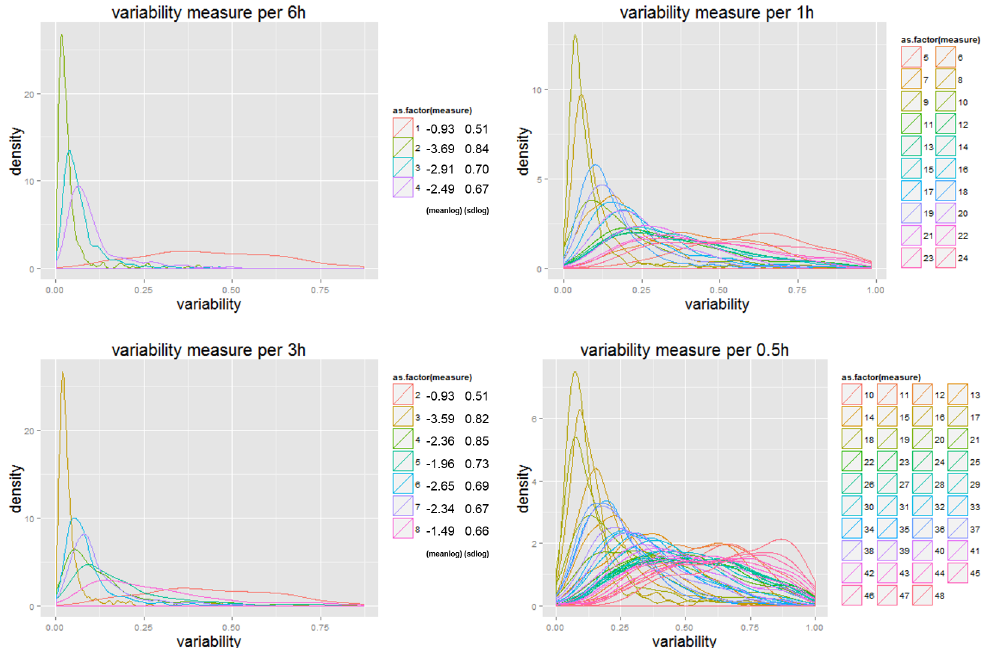
Fig 5. Densities of variability for different time intervals for 400 London underground stations. Note: Less variance exists at a certain time slot, while log normality is consistent over all time slots at all scales. More details about the differences show up when the temporal scale decreases.